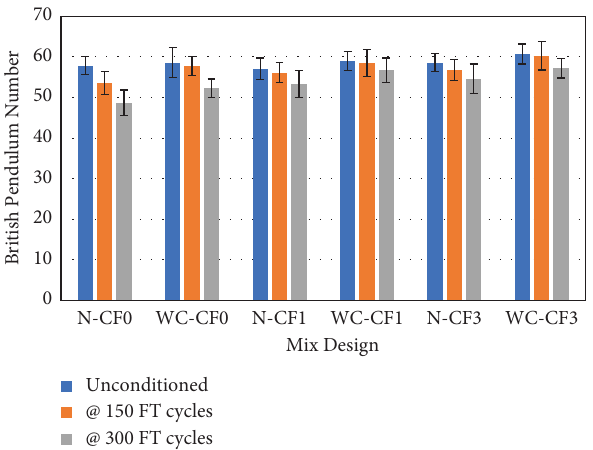
Figure 9: British pendulum number under wet